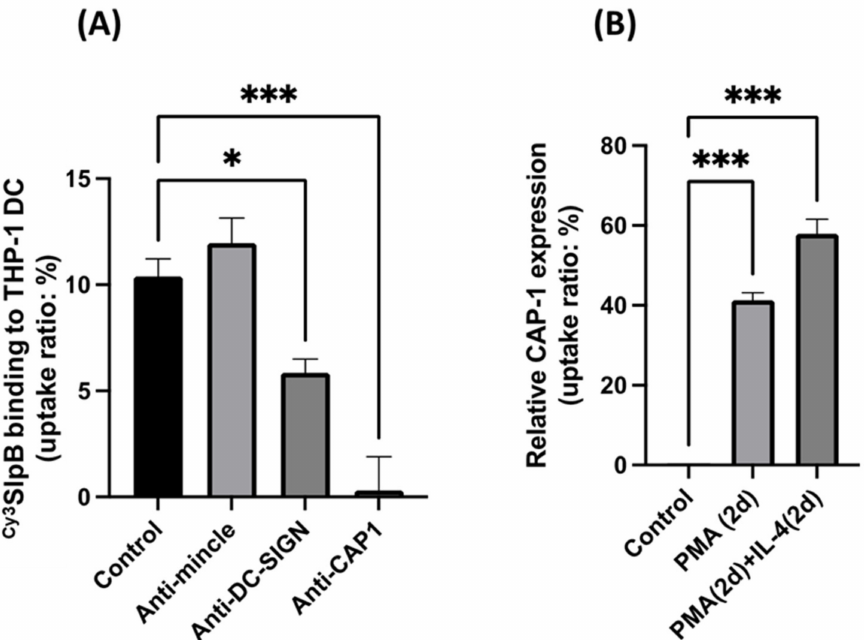
Figure 7. ( A ) Cy3 SlpB was incubated with THP-1 DC with normal mouse serum (Control), anti-Mincle antibody, anti-DC-SIGN antibody, and anti-CAP-1 antibody for 1 h. ( B ) CAP-1 expression in THP-1 DC differentiated with PMA, and PMA and IL-4 ( B ). (Means ± SD. * p < 0.05; *** p <